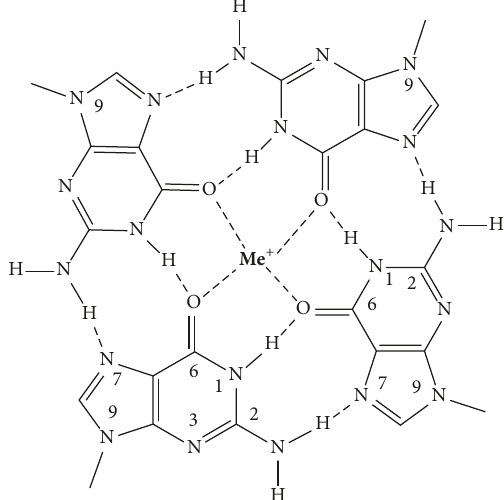
Figure 1: Schematic representation of a G-tetrad held together by Hoogsteen-type circular double hydrogen bonds and the metal